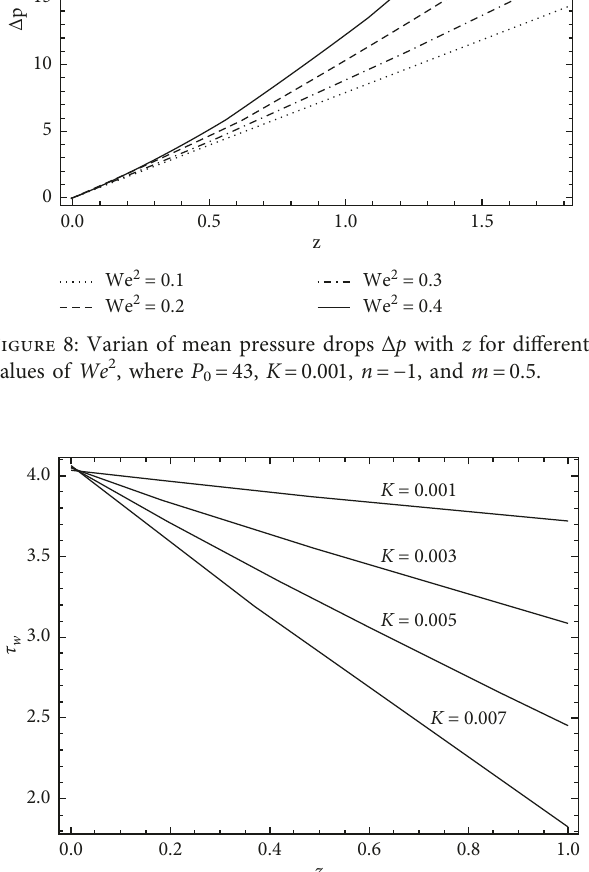
0 for different values of We